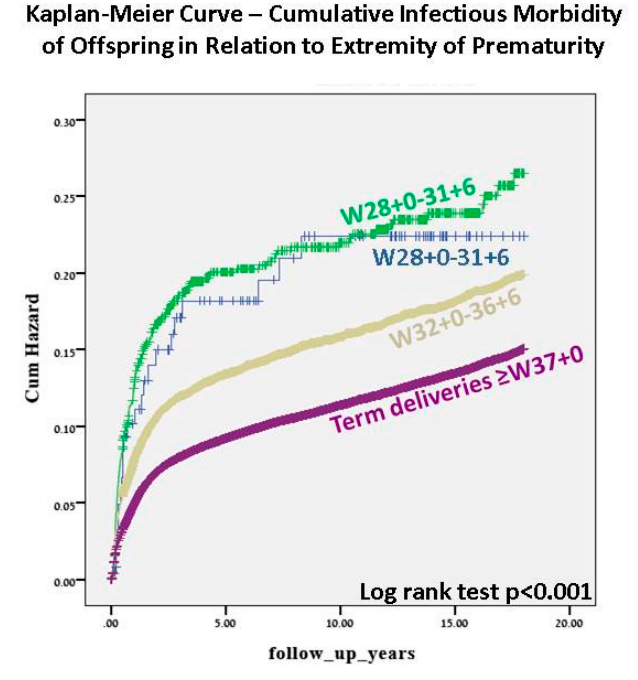
Figure 1. Kaplan–Meier survival curve—cumulative infectious morbidity of offspring in relation to extremity of prematurity.